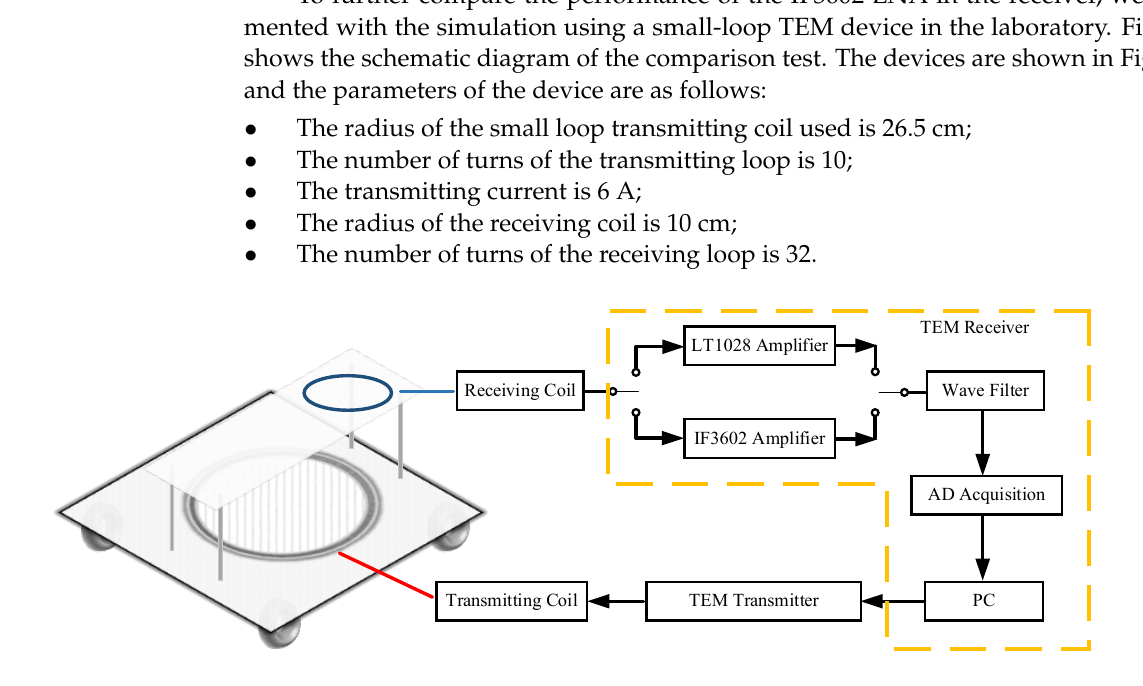
Figure 13. Schematic diagram of laboratory simulation comparison test.